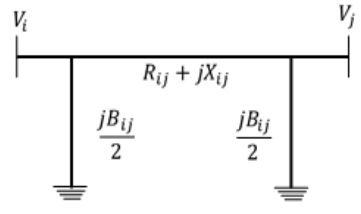
Figure 9. Transmission line π